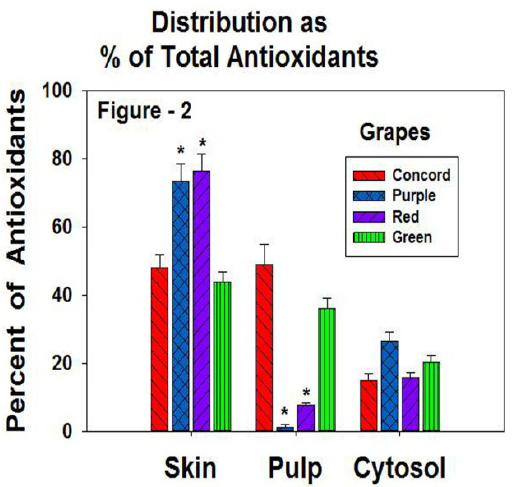
Figure 2. The percent of antioxidant capacity of the skin, pulp, and cytosol. * = significantly different antioxidant capacity of concord and green grapes, p <